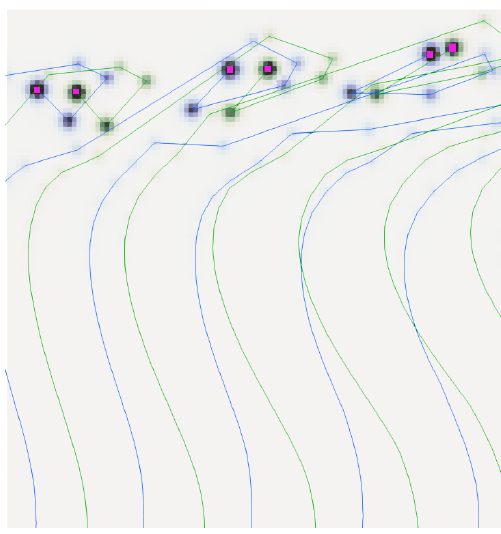
Figure 8. Numerical wake on steps 1 (green) and 5 (blue). Vorticity perpendicular to the plane shown from 0 to 300 1 / s. Lines represent a cut through the wake panels. Pink dots highlight the tip